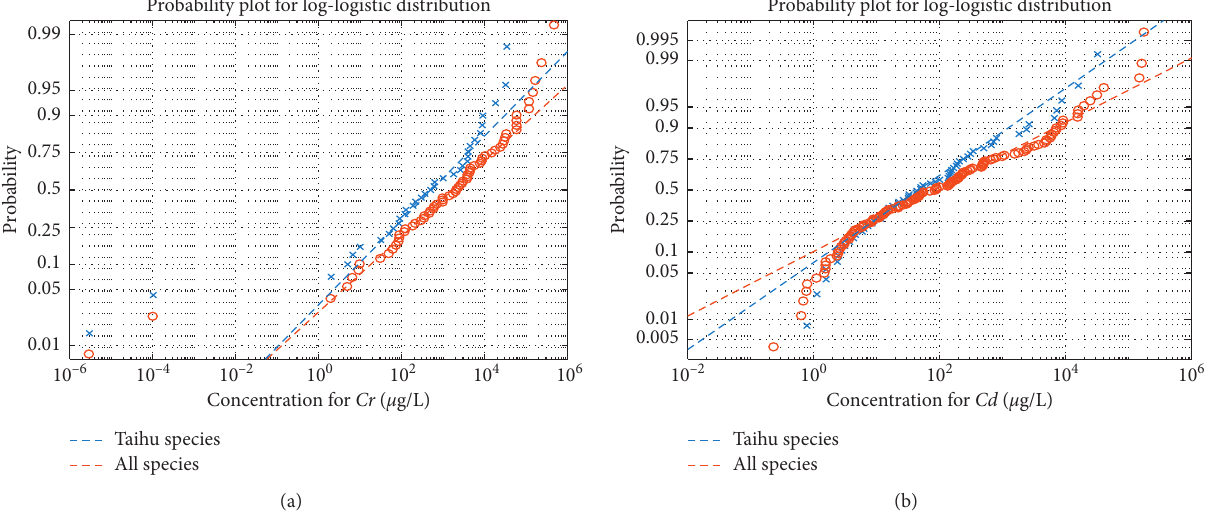
Figure 2: The SSD distributions of Cr and Cd for all species and Taihu